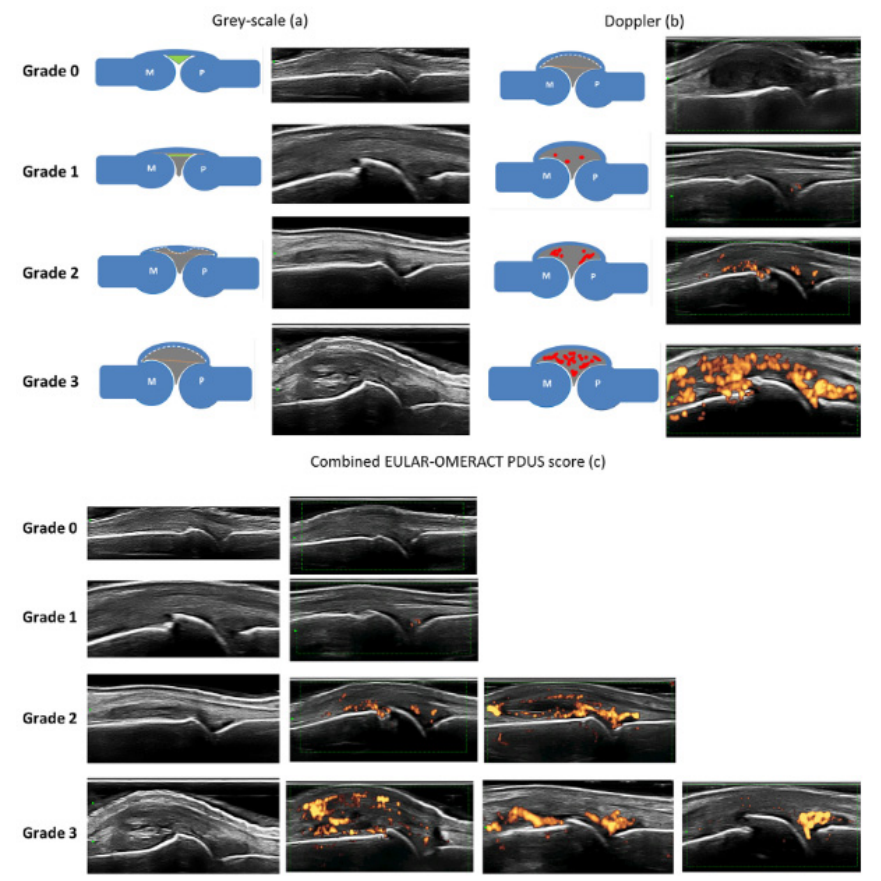
Figure 10. EULAR-OMERACT score examples [17].